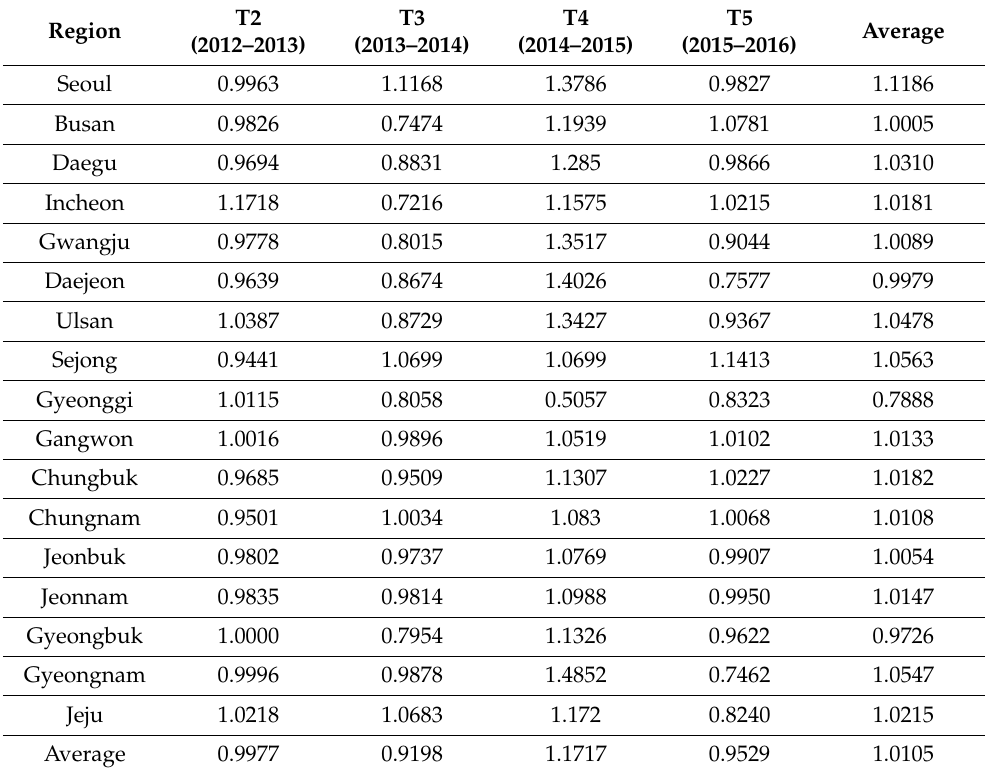
Table 4. Analysis of the change rate of the Malmquist productivity index by